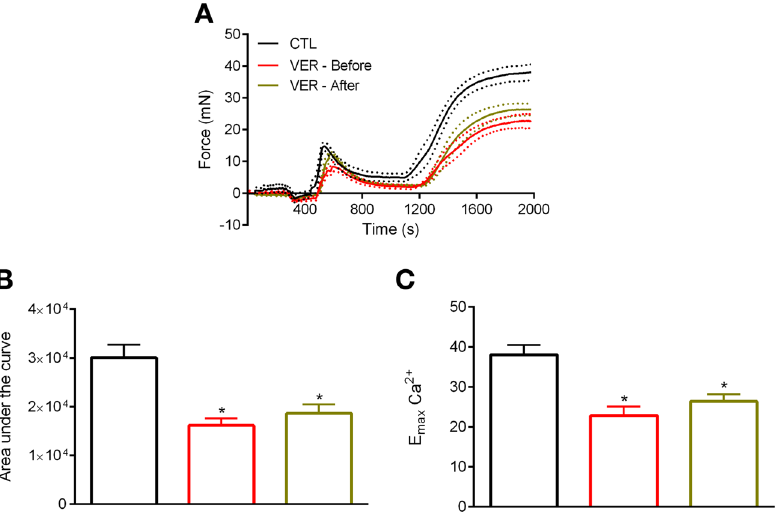
Figure 3. Inhibition of HSP70 attenuates tonic contraction in aorta stimulated with phenylephrine whether VER155008 is added before or after IP3r-mediated phasic contraction. ( A ) Aortic rings were challenged 2 + with phenylephrine ( 10 µ mol/l ) in 0[ Ca ] Krebs’ solution in the presence of vehicle (CTL) or VER155008 2 + ( 10 µ mol/l , DMSO diluted), which was added before or after IP3r-mediated Ca release. The concentration 2 + of Ca was restored after 10 min, and the force developed was evaluated for 15 min. ( B ) Area under the